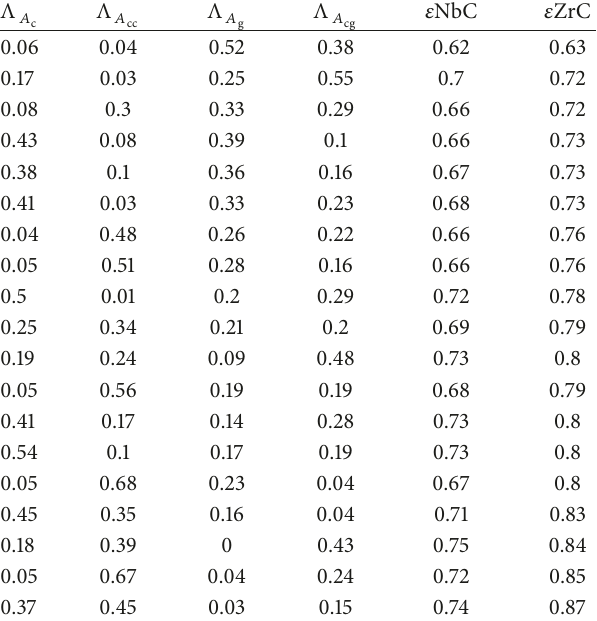
Table 7: Flow areas, lengths, and volumes of RELAP